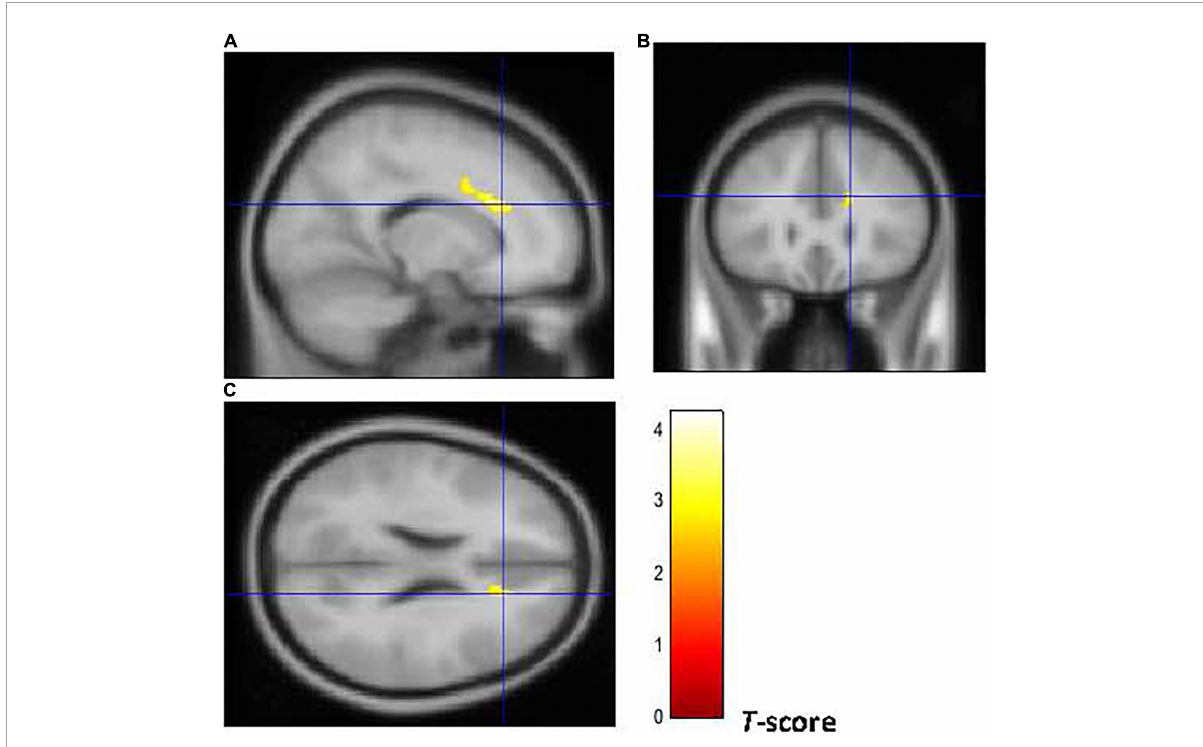
FIGURE2 Brain regions of interest displaying lower GM volume in early onset smokers in comparison to non-smokers. The figure shows early onset smokers to display lower GM volume in the right ACC [region of interest centered at 16, 28, 24 MNI coordinates in sagittal (A) , coronal (B) , and axial (C) planes] in comparison to non-smokers. The cluster-forming threshold consisted in p < 0.01 with a minimum of 100 voxels per cluster at a whole-brain corrected level. TIV, age, and biological sex were inserted as covariates of no